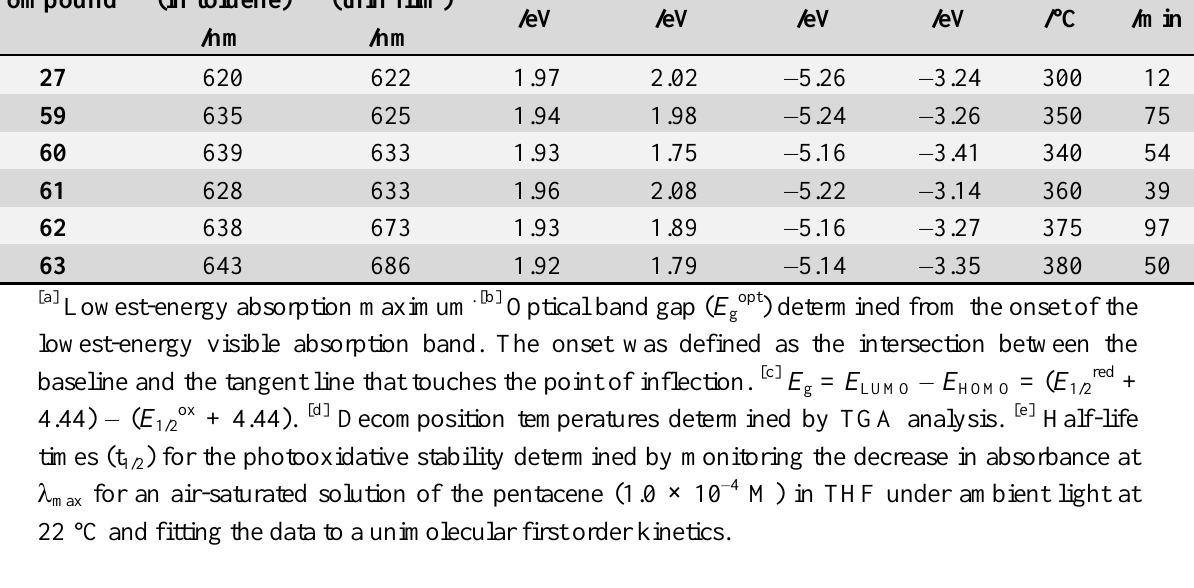
Table 1 . Properties of 6,13-disubstituted pentacenes with oligothiophenes. Compound